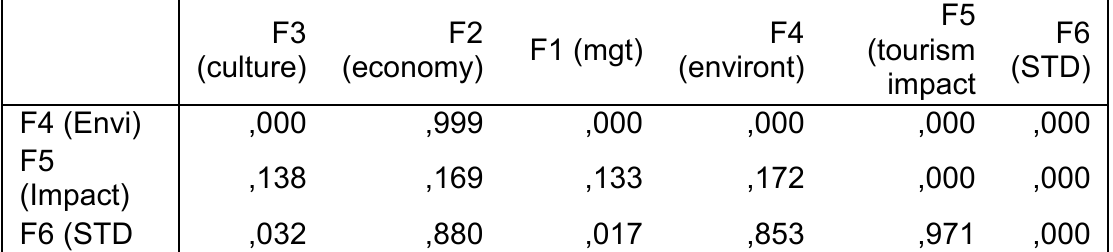
Table 6. Standardized Direct Effects